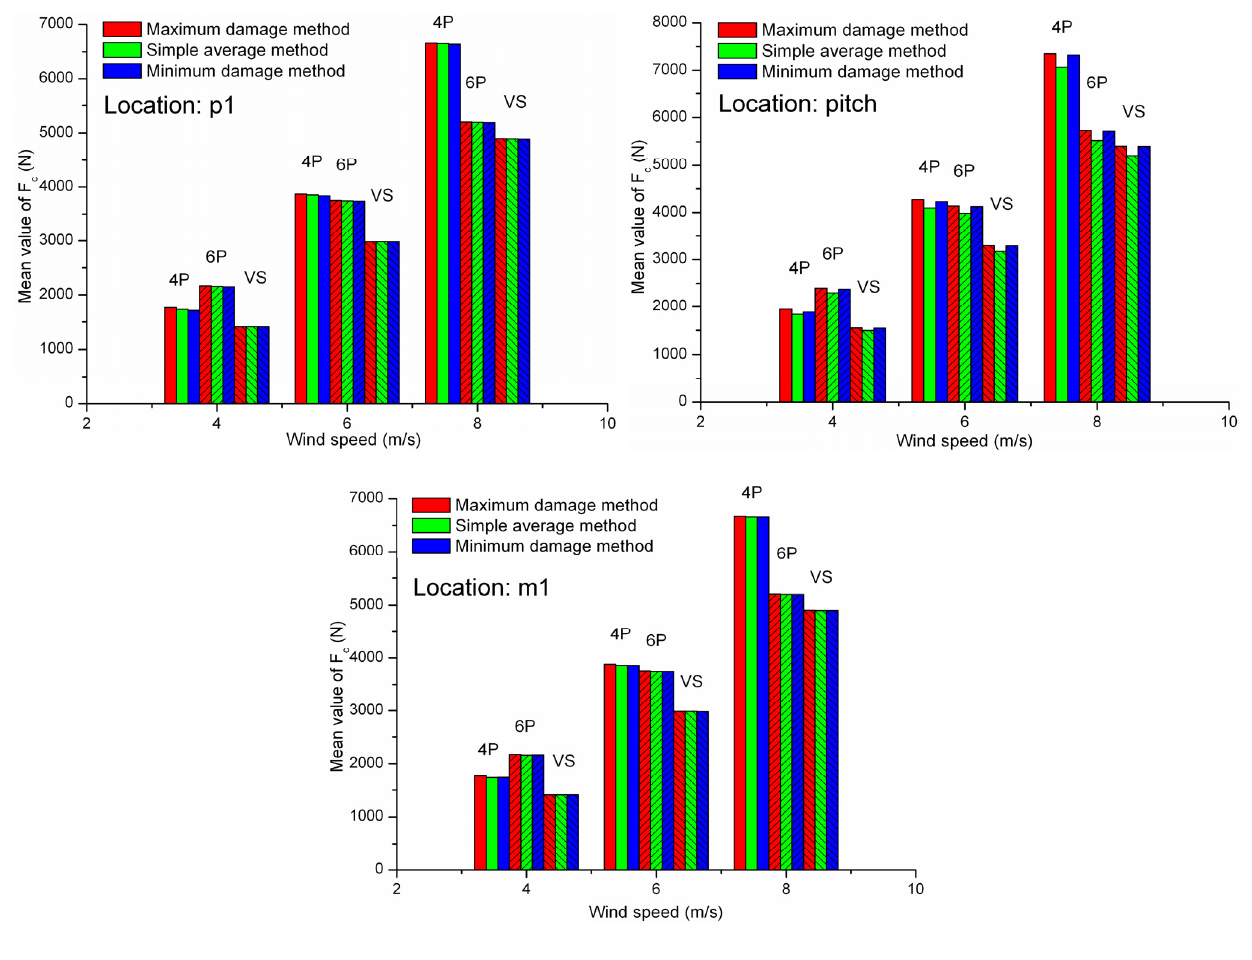
Figure 22. Comparison of mean contact forces when using different methods at different contact points, generators and wind